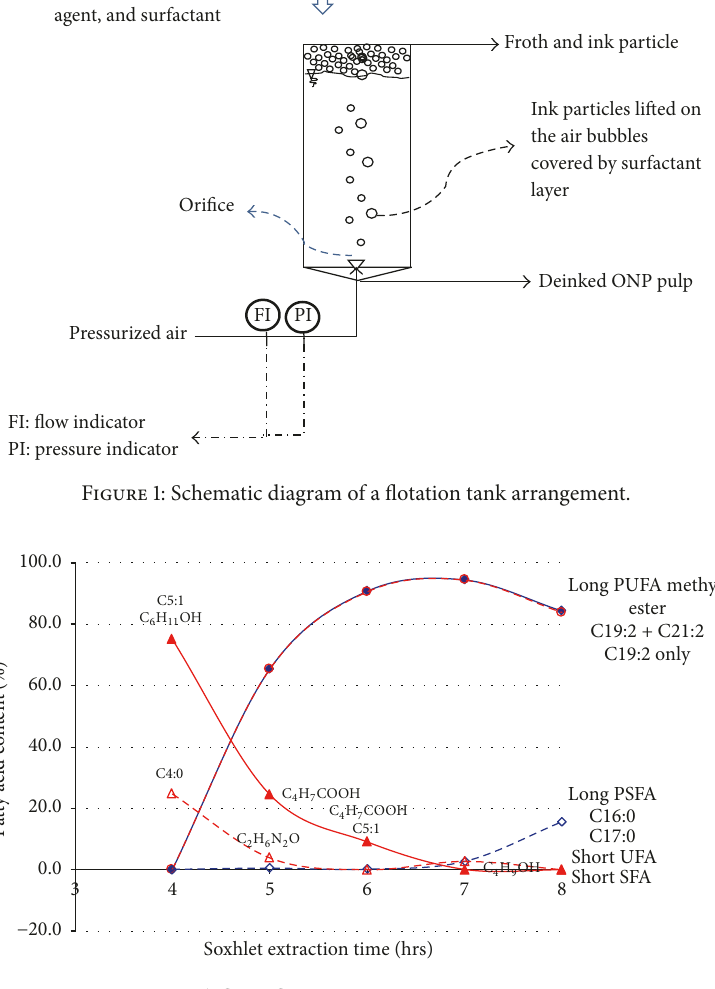
research concerning the effect of Soxhlet extraction and maceration on fatty acid composition [14] and concerning the effect of extraction time on omega-3 content [15].